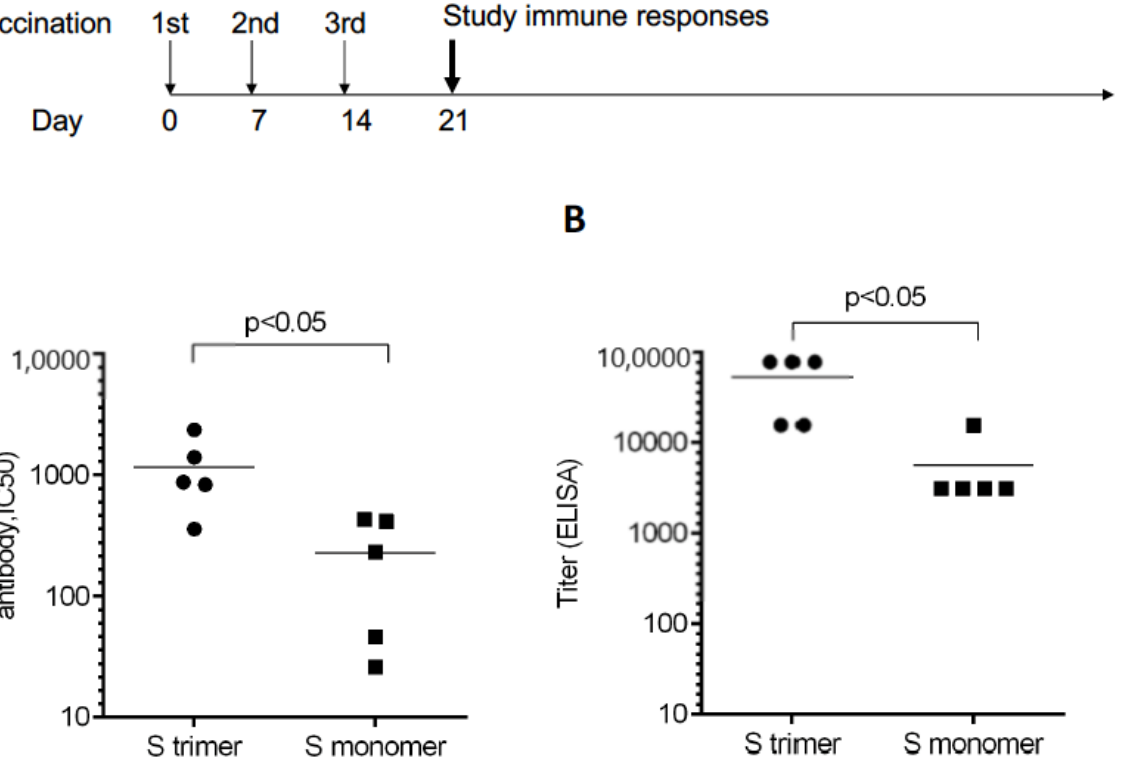
Figure 1. Antibody titers measured by neutralizing assays and ELISA. Mice were immunized by Spike trimer or monomer proteins containing PIKA adjuvant by a 0–7–14 day schedule. ( A ) The neutralizing titer as measured by pseudo-virus with Figure 1 Antibody titers measured by neutralizing assays and ELISA . Mice were immunized by Spike trimer or monomer monoclonal antibodies 40592-MM57 and 40591-MM43 as the control (with IC50 at 1 µ g/mL). ( B ) Antibody titer as measured proteins containing PIKA adjuvant by a 0 – 7 – 14 day schedule. ( A ). The neutralizing titer as measured by pseudo-virus by ELISA using the plate-bound trimeric Spike protein. Data were representative of three independent